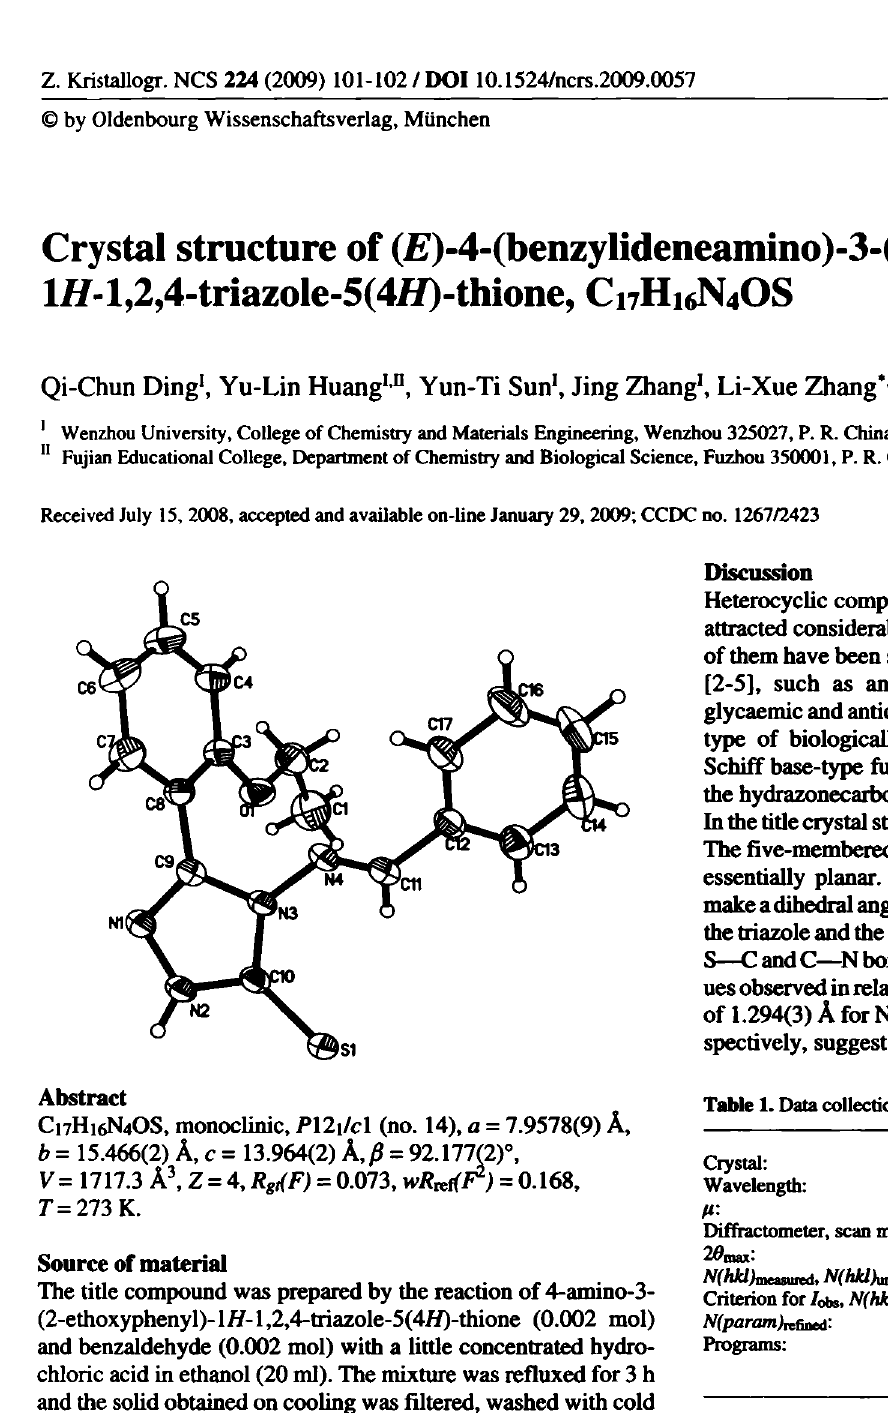
Table 2. Atomic coordinates and displacement parameters (in Â 2